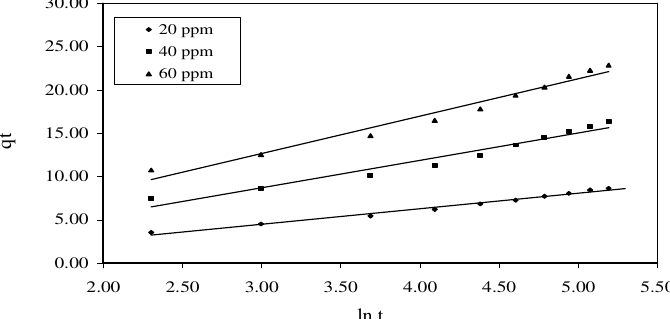
Figure 2b. Elovich plot of Reactive Red 2 removal - initial dye concentration